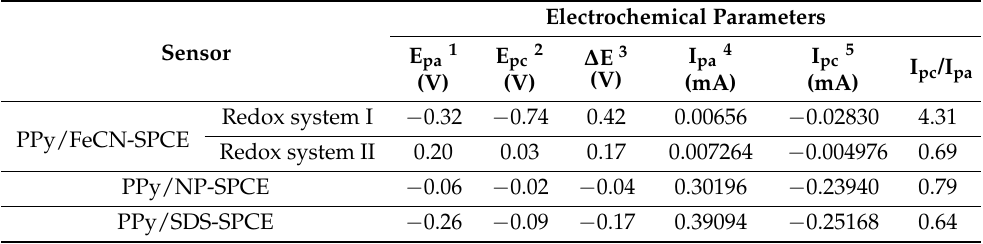
Table 2. The potential and intensity of peaks of PPy modified sensors and immersed in a 0.1 M KCl solution at scan rate of 0.1 V × s − 1 .